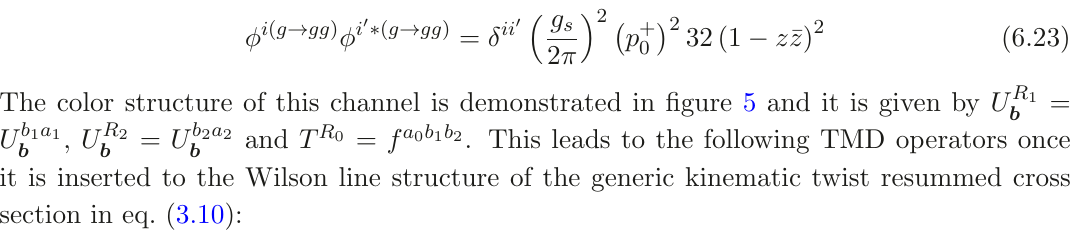
gg amplitude in an external shockwave background with the appropriate color →